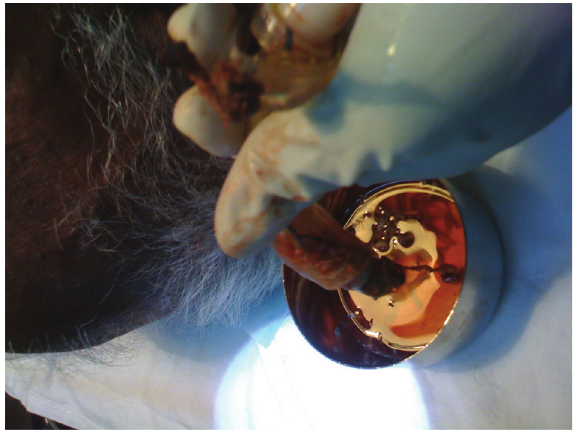
Figure 3: The blocked tracheostomy tube at presentation.